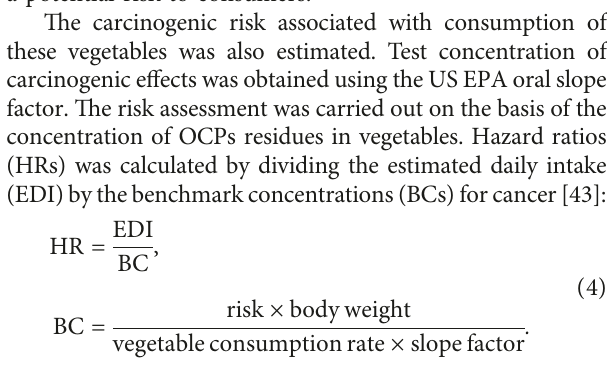
(Table 1). Method detection limits (Table 1) were computed